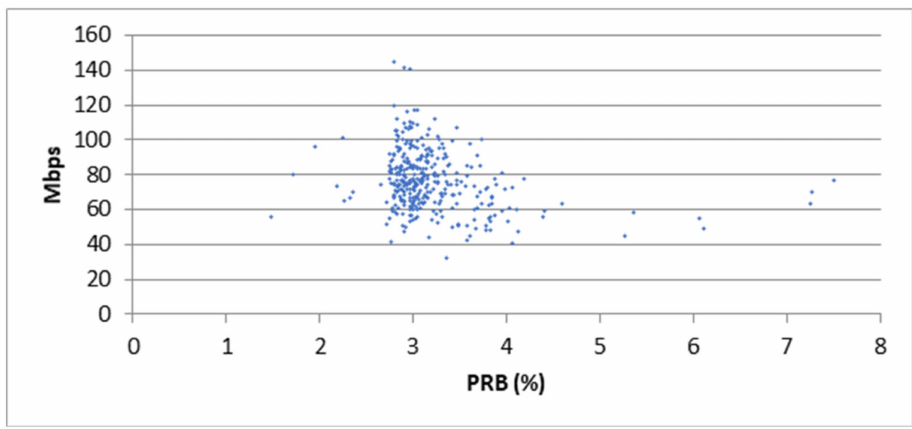
Figure 7. Cell throughput vs. PRBs used for 60